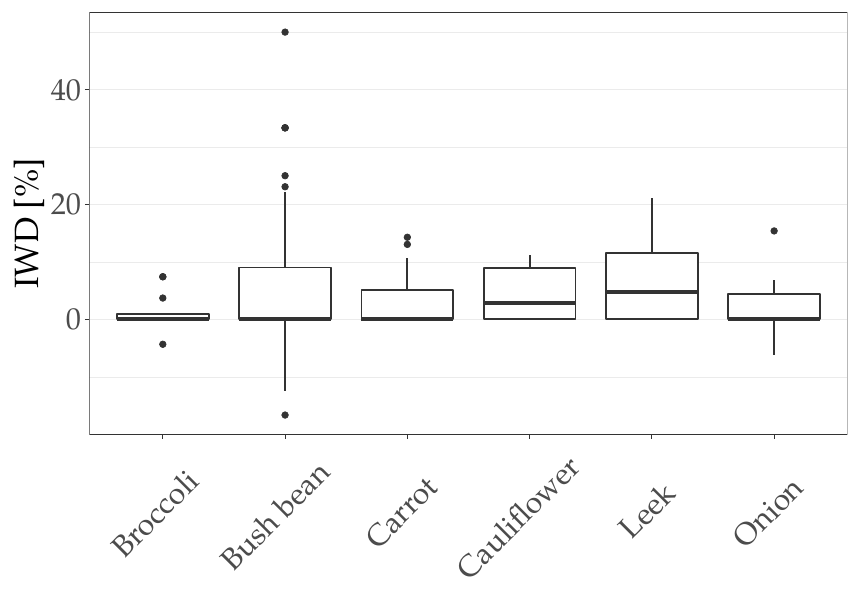
Figure 5. Boxplot of relative irrigation water differences (IWD %), GS P 2 for the six vegetable crops. Black line = median, Boxes = second and third quantile, points = outliers.